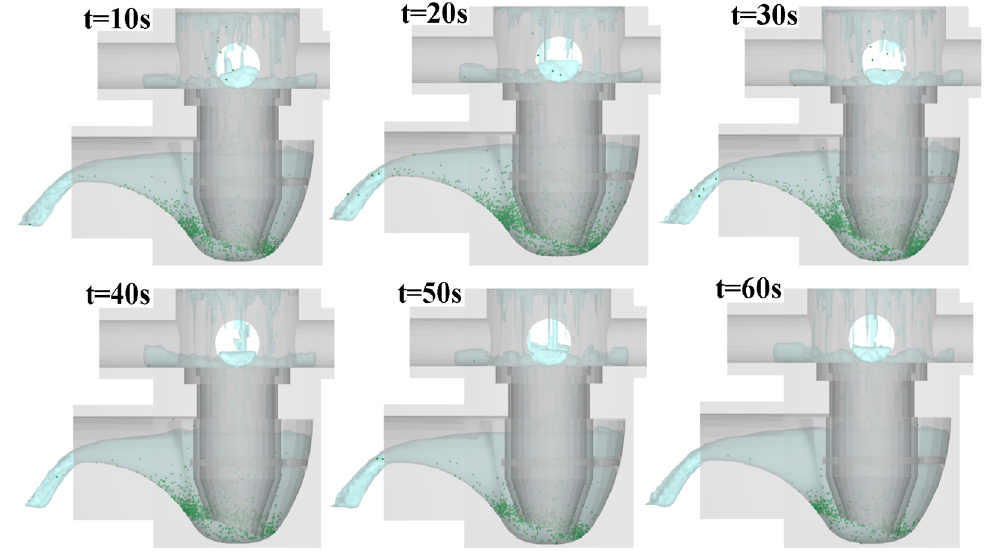
Figure 6. Temporal variations of glass ball transportation through gully with beveled nozzle flow at entry water flow rate of 0.6 L/s.